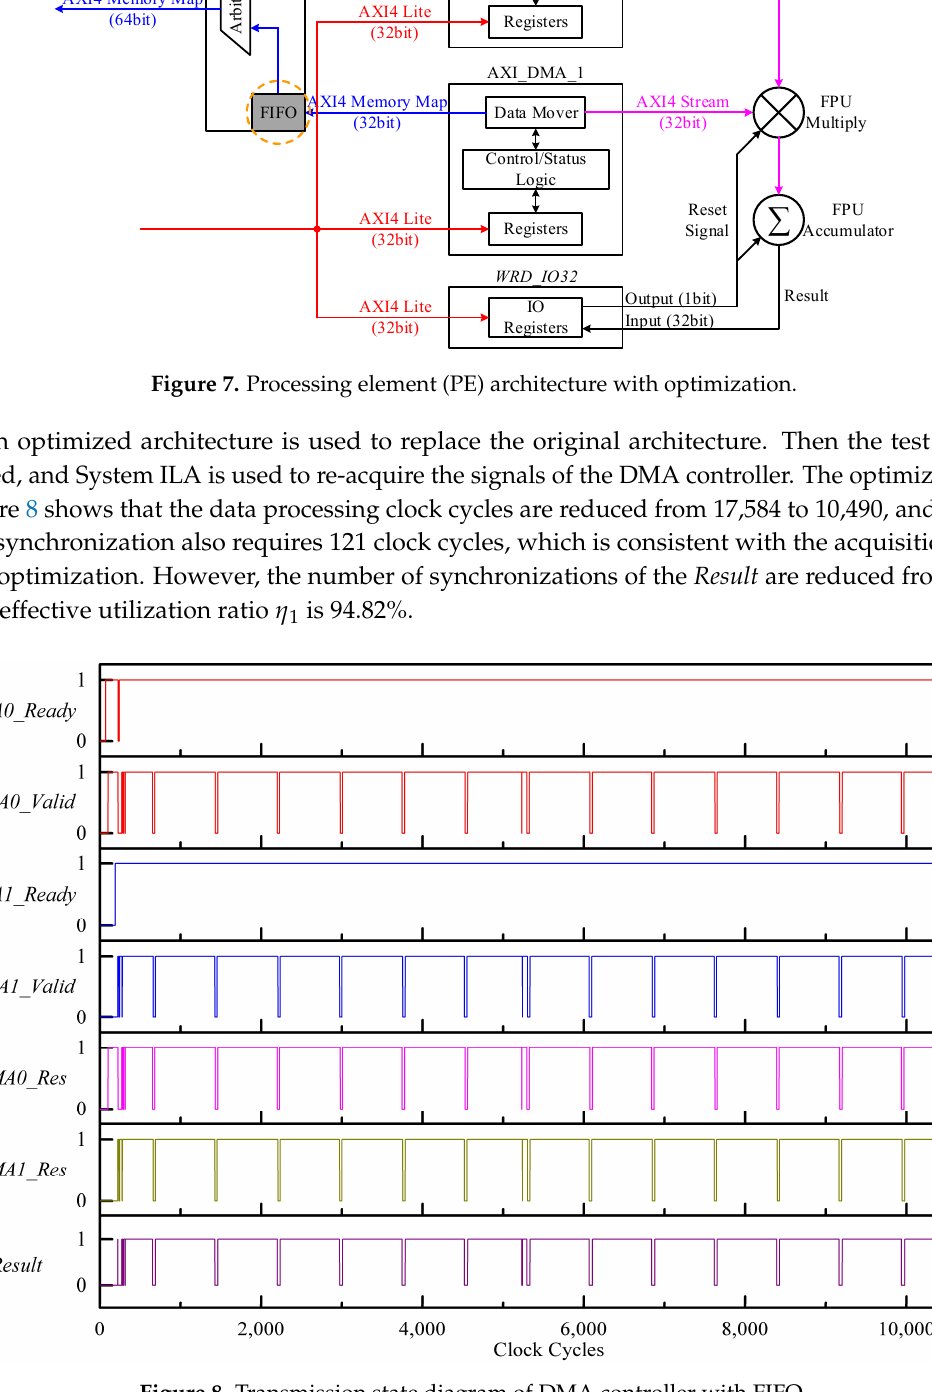
Figure 8. Transmission state diagram of DMA controller with FIFO.